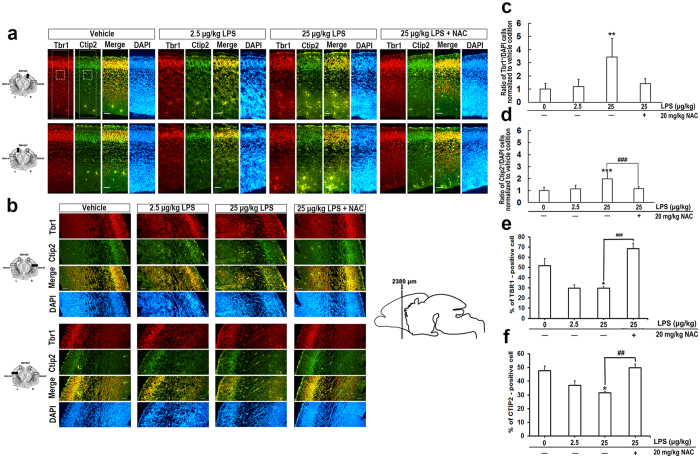
NAC mollified the abnormal cortical lamination in the developing embryonic brain after maternal exposure to LPS.Coronal sections of indicated GD 18 rat embryonic brains were immunostained for Tbr1, Ctip2 and DAPI. Tbr1 indicates the cells in cortical layer VI, while Ctip2 labels layer V cells. Merged image is composed of Tbr1 (red), Ctip2 (green). DAPI (blue) represents each nuclei. Five embryo brains were randomly selected from at least three different pregnant rats. In each brain, two coronal sections near the site around 2380 μm from the front of olfactory bulb were analyzed. Representative images of the sections at cortical (a) dorsal and (b) lateral areas are shown. Both Ctip2+ and Tbr1+ cells are scatteredly distributed in LPS treated group comparing to vehicle exposed and NAC treated fetus. Scale bar, 50 μm. (c) and (d) display the quantitative results of the small dashed square. The dorsal area of cortex was divided into 3 equivalent bins, with the border between bin 1 and bin 2 corresponding to the edge of intermediate zone or the area just fall off the cortical plate, as the dotted area. Ratio of Tbr1+/DAPI and Ctip2+/DAPI in each condition was normalized to the vehicle. Application of LPS results in majority of theTbr1+ and Ctip2+ cells remaining inside the intermediate zone, and meantime NAC returned the ratio to vehicle condition. *Statistically different from vehicle condition without NAC. #Statistically different from each LPS dosage compared to NAC. **p < 0.01, ***p < 0.001 by ANOVA followed by Bonferroni multiple comparisons test or Dunn’s multiple comparisons test. (e,f) display the quantitative results of the large dotted square, as same as the area counted for BrdU. Number of Tbr1+ or Ctip2+ cell was normalized to the number of DAPI+ cell. LPS caused significantly less Tbr1+ and Ctip2+ cells expressed, and meantime NAC had rescue effect. *Statistically different from vehicle condition without NAC. #Statistically different from each LPS dosage compared to NAC. *p < 0.05, **p < 0.01, ***p < 0.001 by ANOVA followed by Tukey-Kramer Multiple Comparisons Test.